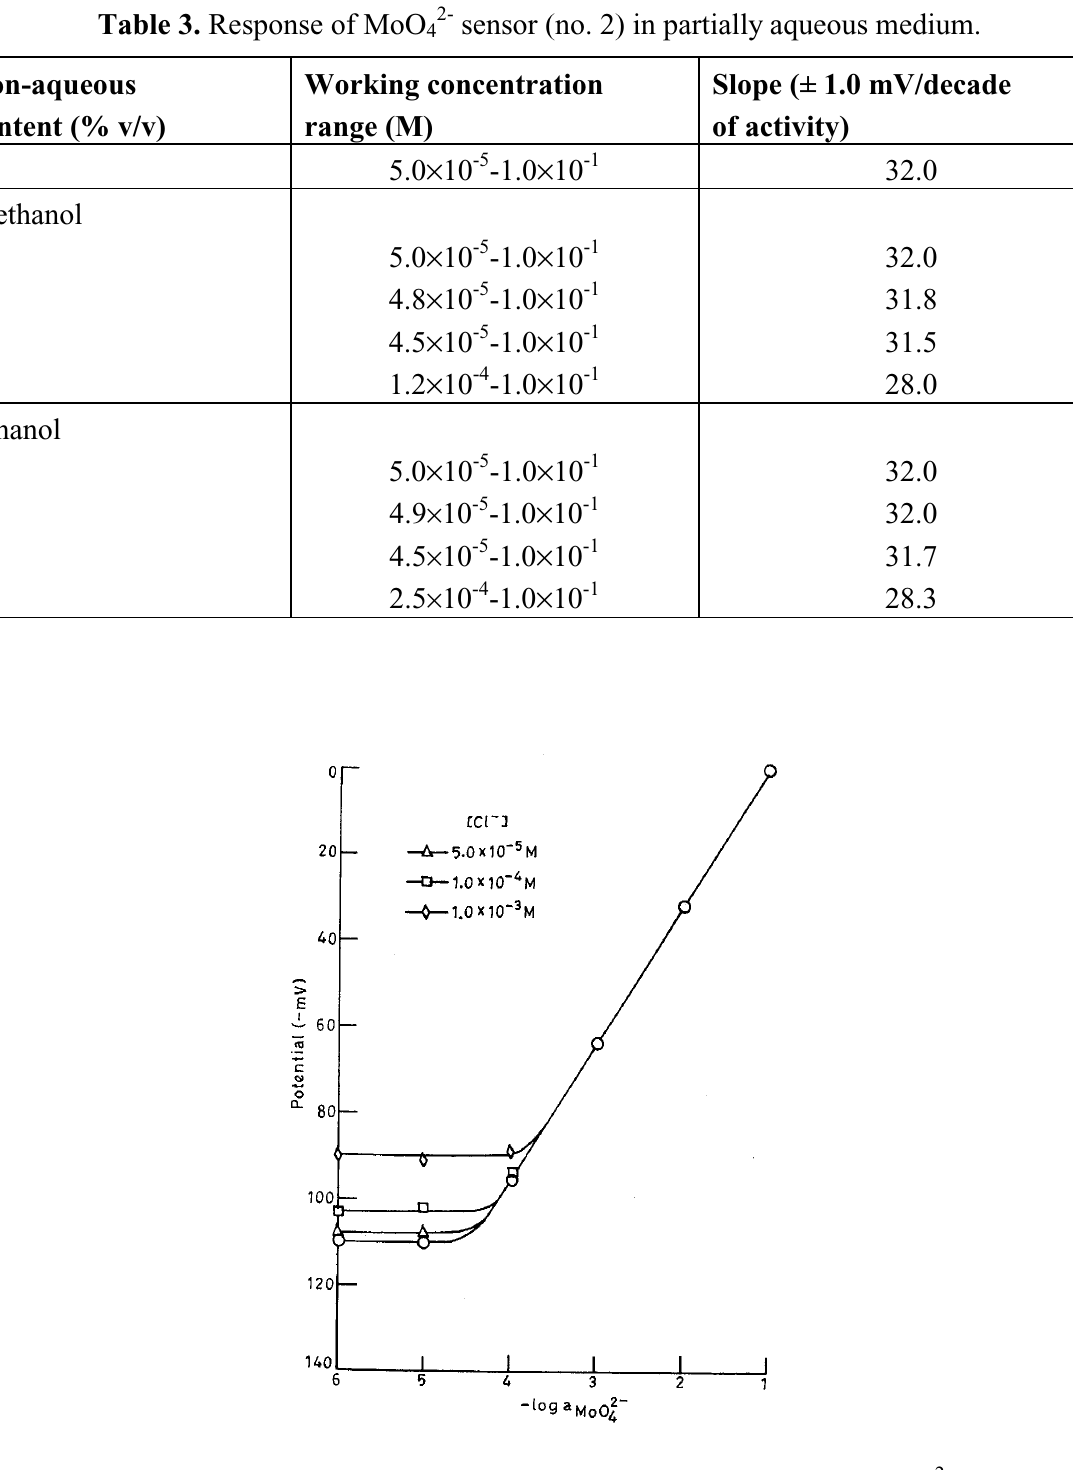
Figure 3. Variation of cell potential with varying concentrations of MoO 42- at different concentration levels of Cl - for ( I )